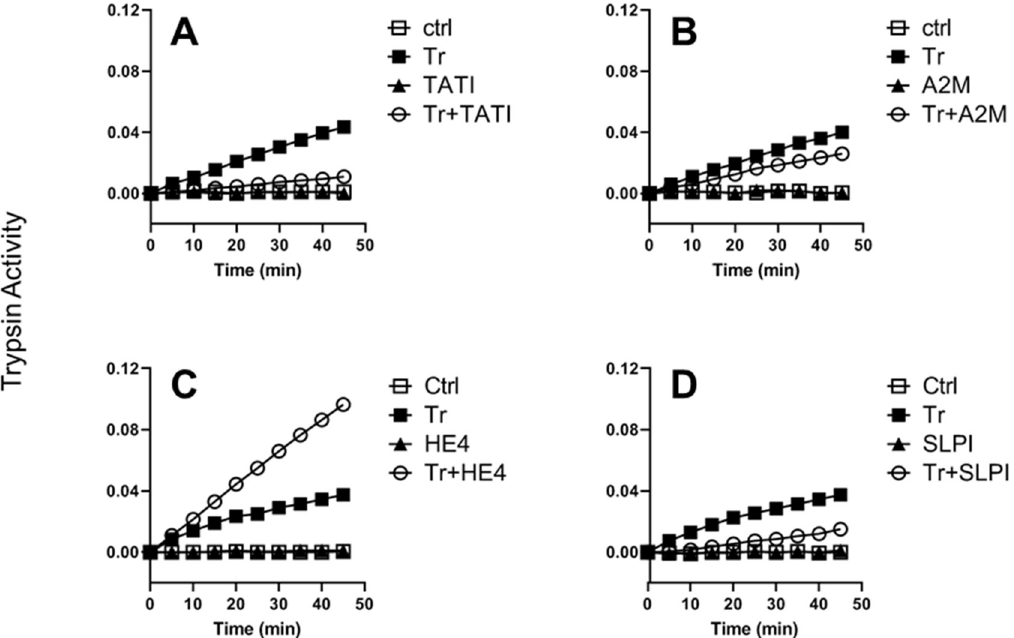
Fig 4. HE4 potentiates trypsin activity. Trypsin activity was measured by the proteolytic cleavage of its substrate ( N α -benzoyl- DL-arginine p -nitroanilide). The release of p -nitroanilide was colorimetrically detected ( λ = 415 nm). Y-axis: value–baseline. Tr: trypsin; TATI: tumor-associated trypsin inhibitor; SLPI: secretory leukocyte protease inhibitor; A2M: α -2-macroglobulin. See Methods for detailed protocols.